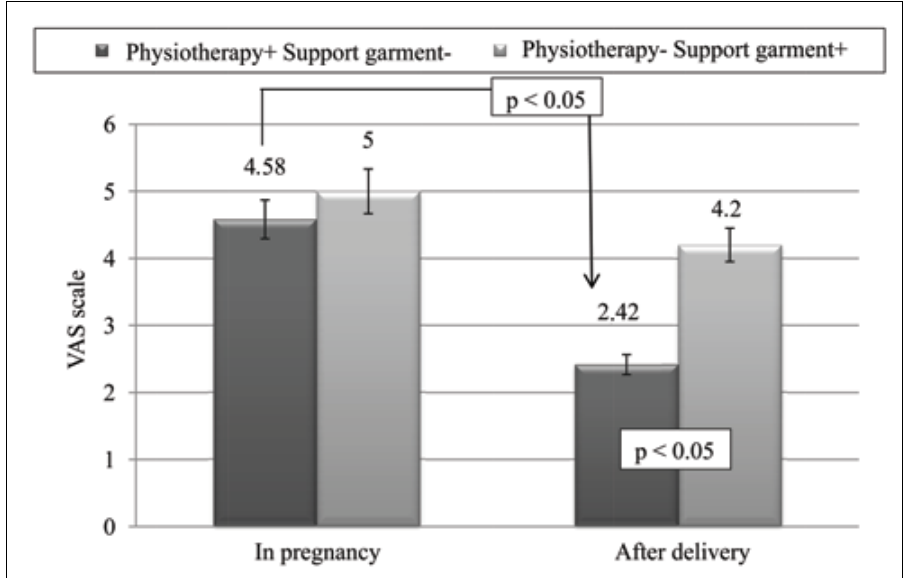
Figure 1. Low back pain differences depending on presence (+) or absence (–) of physiotherapy and maternity support